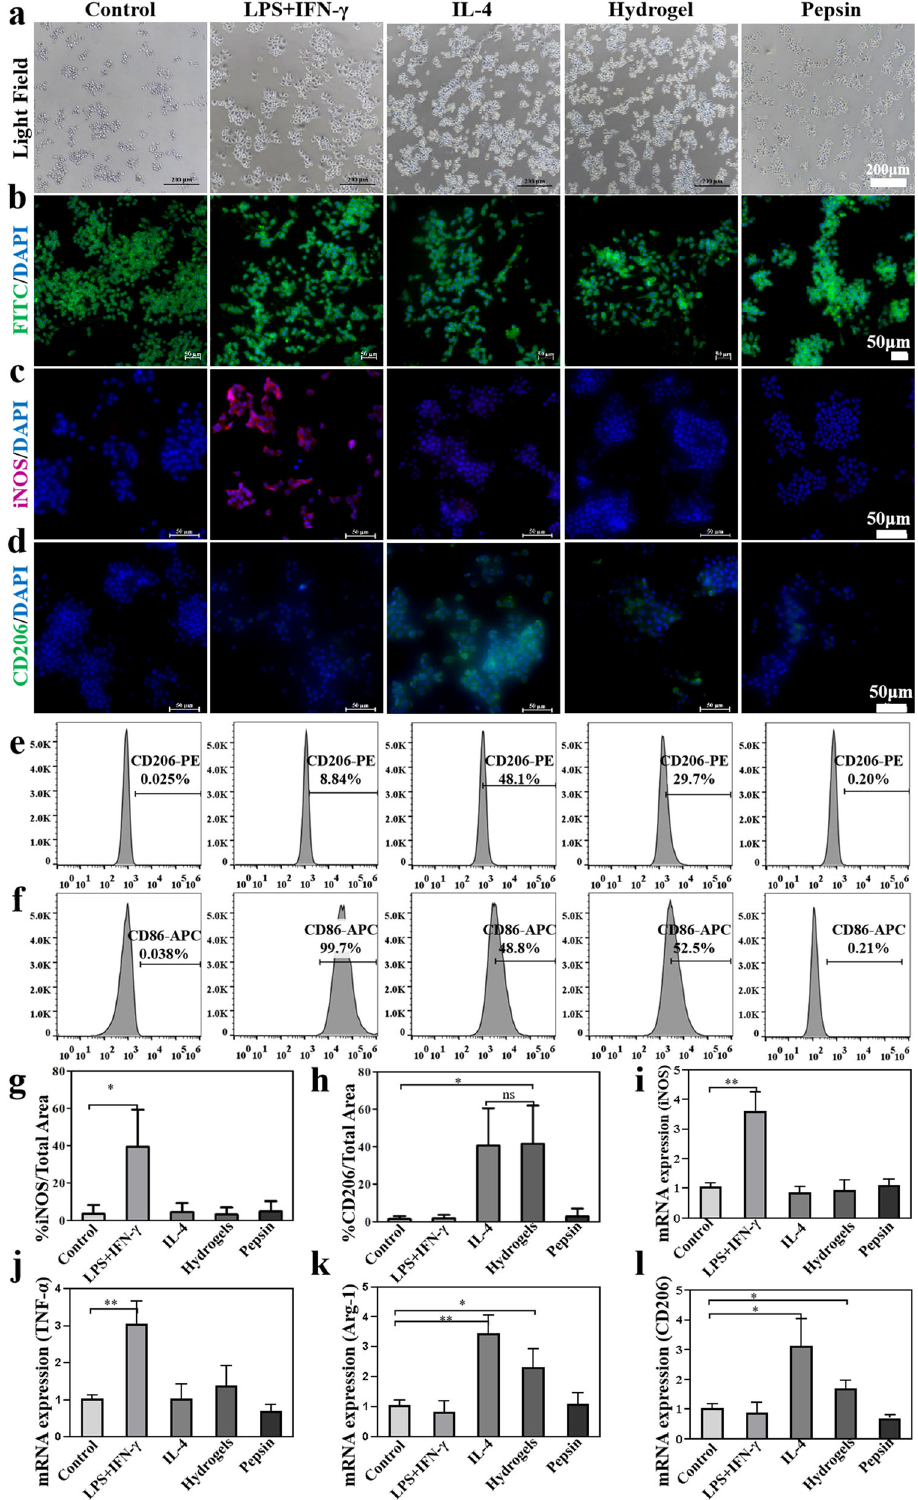
Fig. 5 Raw 264.7 was co-cultured with dECM hydrogel in transwell and the immunomodulatory capacity assessment. a Bright- fi eld image of the RAW264.7 cells treated with various stimuli for 48 h. Scale bar = 200 μ m. b Morphology of the cells stained with FITC Phalloidin for the cytoskeleton (green) and DAPI for the nucleus (blue) after 48 h. Scale bar = 50 μ m. c , d Immuno fl uorescence of iNOS and CD206 expression treated by different groups. Scale bar = 50 μ m. e , f Representative images of surface markers CD86 and CD206 of RAW264.7 analyzed by fl ow cytometry. g , h Semi-quantitative analysis of immuno fl uorescence staining results. i – l The expression of in fl ammatory cytokines iNOS, TNF- α , ARG-1, and CD206 was detected by RT-qPCR. ns, not signi fi cant; * P < 0.05, ** P < 0.01, *** P < 0.001, * is the statistical difference compare with Control group. One-way ANOVA followed by the Tukey post hoc test was used. Each data point represents average ± standard deviation, n =